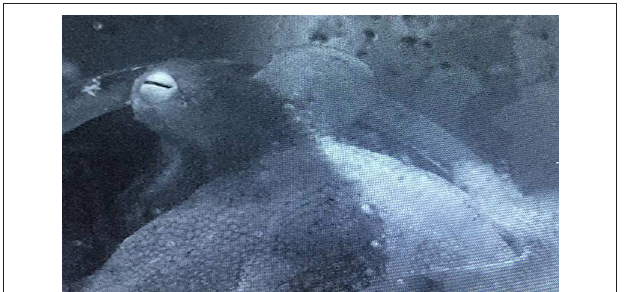
FIGURE 3 | Octopus unilateral body pattern